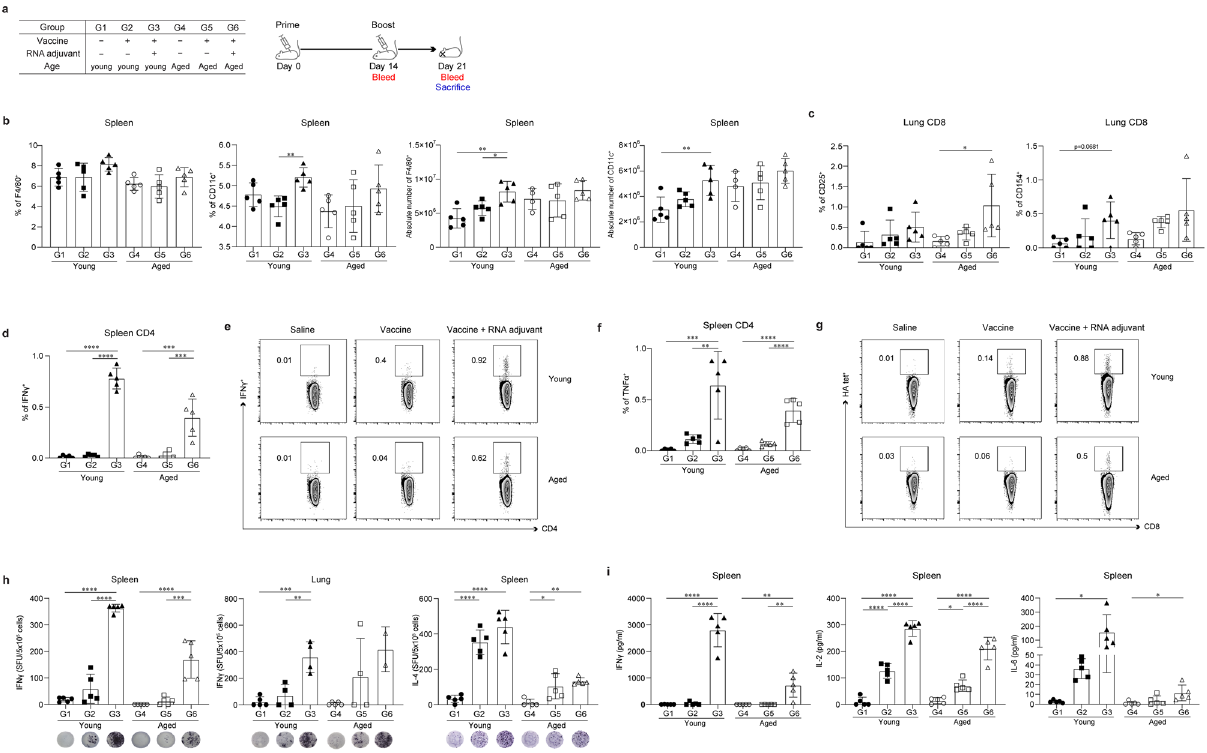
Figure 4. Inactivated influenza vaccine (IIV) formulated with ssRNA increases antigen-presenting cells, activation markers, and cytokine production in T cells. BALB/c mice were intramuscularly immunized with 0.6 μg of IIV with or without ssRNA adjuvant at an interval of 2 weeks. Splenocytes and lung lymphocytes were harvested 1 week after the boost schedule. To detect cytokines, cells were stimulated for 16 h for FACS analysis, for 2 days for ELISPOT assays, and for 3 days for conducting ELISA with or without IIV. Data are represented as mean ± SD and were statistically analyzed by one-way ANOVA. The significance of differences between groups are indicated by bars and symbols as follows: *p < 0.05; **p < 0.01; ***p < 0.001; ****p < 0.0001. n = 5 mice for G1, G2, G3, G5 and G6. n = 4 or 5 mice for G4. ( a ) Immunization groups and schedule. ( b ) Percentages and absolute number of macrophage and dendritic cells in young and aged mice splenocytes. ( c ) Percentages of CD25 and CD154 in young and aged mice lung lymphocytes. Percentages of ( d , e ) IFN-γ and ( f , g ) TNF-α in young and aged mice splenocytes. ( h ) Spots of influenza HA-specific IFN-γ- and IL-4-producing cells among splenocytes and lung lymphocytes measured by ELISPOT. ( i ) Concentration of influenza HA-specific IFN-γ, IL-2, and IL-6 in splenocyte culture supernatant measured by